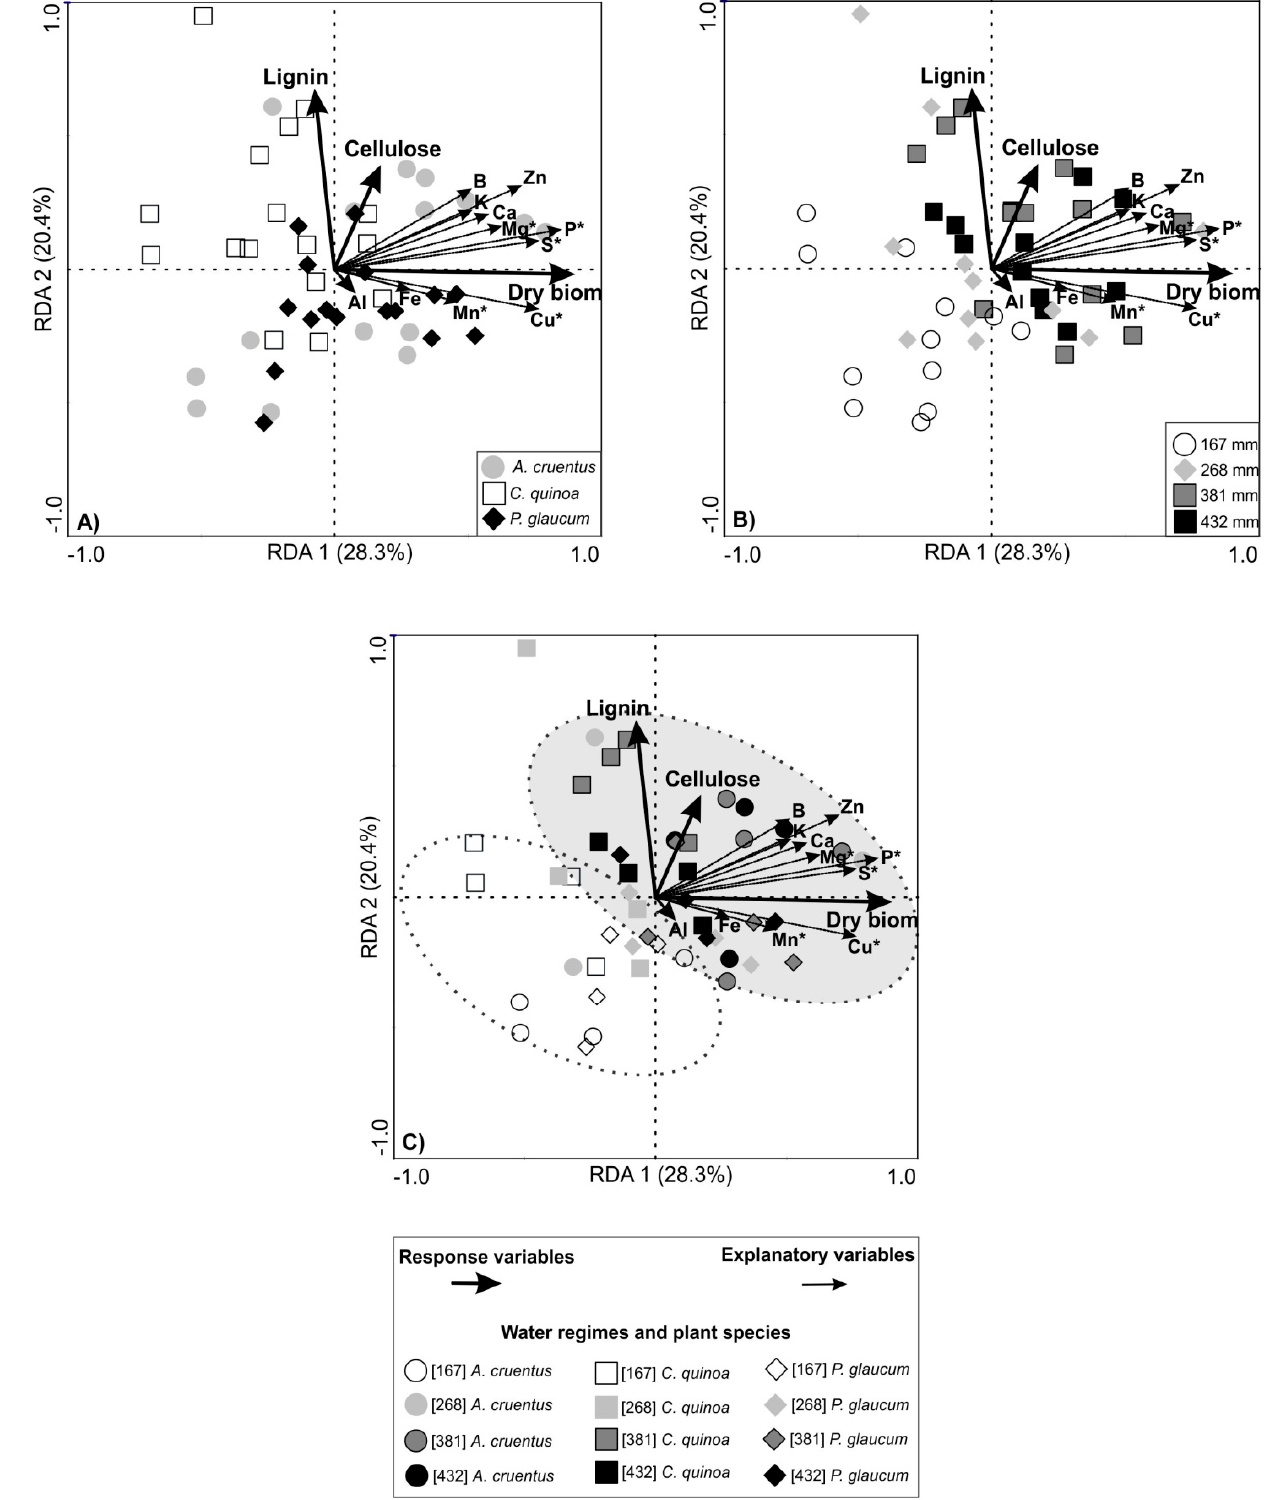
Figure 2. Order diagram of the redundancy analysis (RDA) with the explanatory variables (P, K, S, Al, Fe, Cu, Ca, Mn, Mg, B and Zn) and the variable responses (lignin, cellulose and dry biomass contents) based on the Monte Carlo permutation test (permutation = 999) distributed according to plant species ( A ; n = 16), water regime ( B ; n = 12) and both ( C ; n = 4). Asterisk denotes significance ( p < 0.05), according to Table 6.